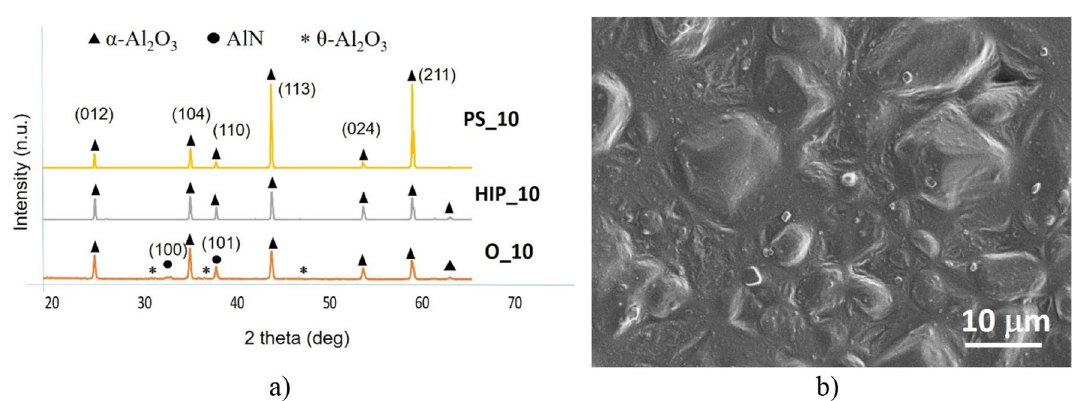
Figure 7. Investigation of oxidized AlN at 10 h. ( a ) XRD plots of oxidized AlN powder (O_10), HIP sintered (HIP_10) and sintered at